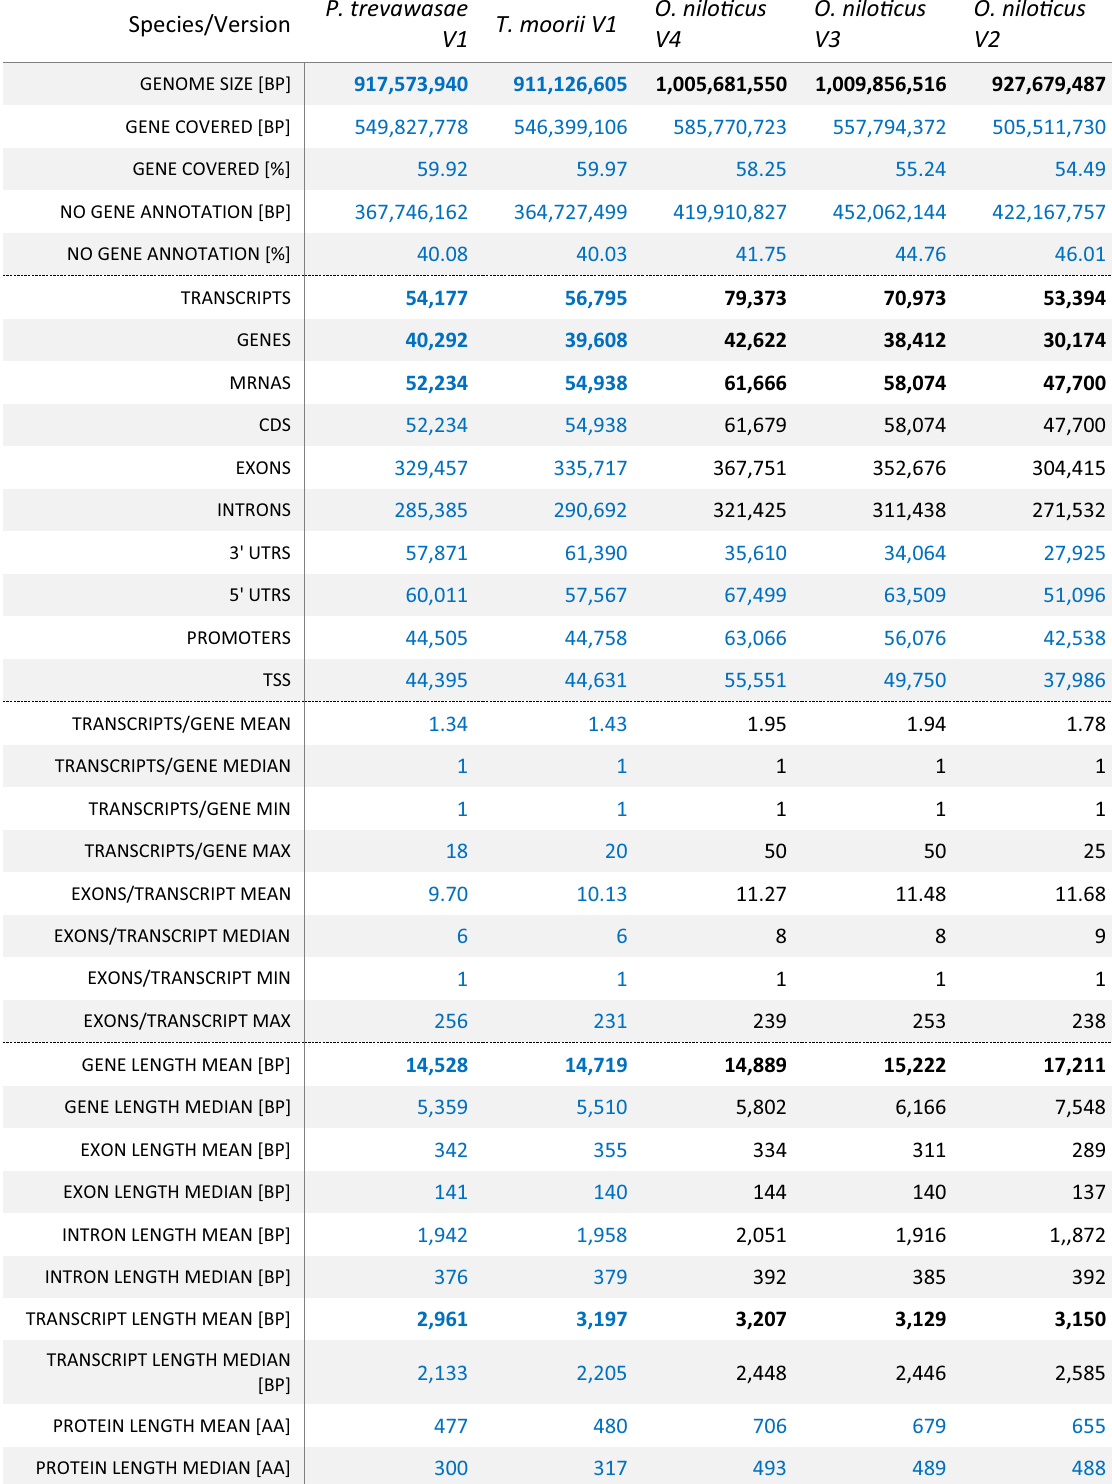
Table 2. Structural annotation statistic of PT and TM in comparison with ON: Structural annotation yielded ~ 40,300 and 39,600 genes, respectively. This is in line with the results of different annotation versions of ON (~ 30,200 to